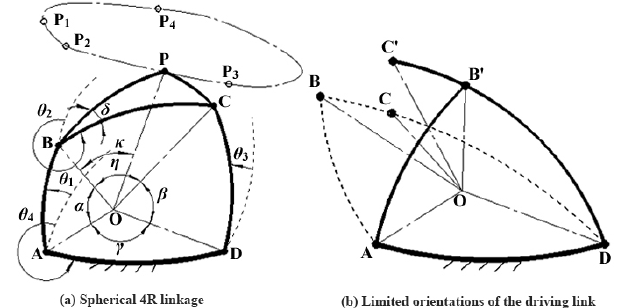
Figure 3. Spherical 4R linkage located at the limited